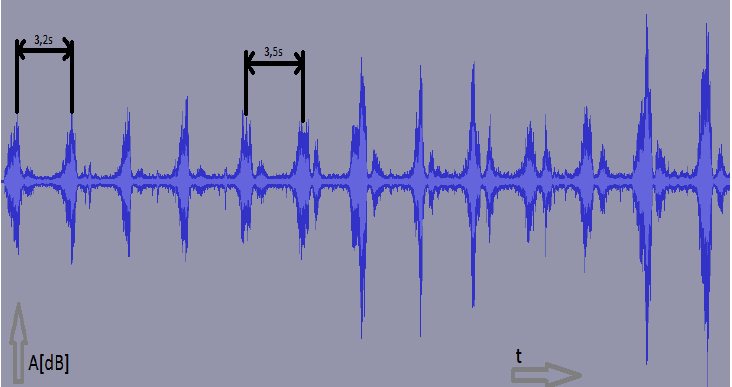
Figure 2. Example of snoring sound obtained during